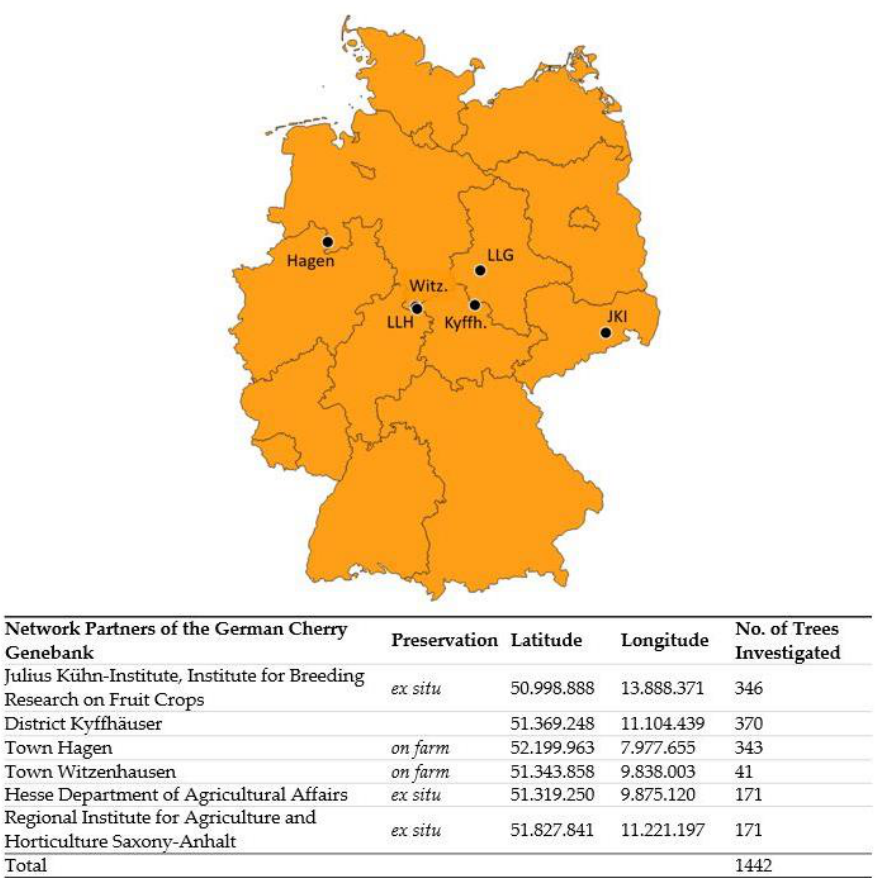
Figure 5. Cherry network collections of sweet cherry of the German Fruit Genebank investigated. Geographic location and the number of trees evaluated for trueness-to-type, preserved at six differ- ent locations in Germany. Hagen: Town Hagen a. T. W.; JKI: Julius Kühn-Institute, Institute for